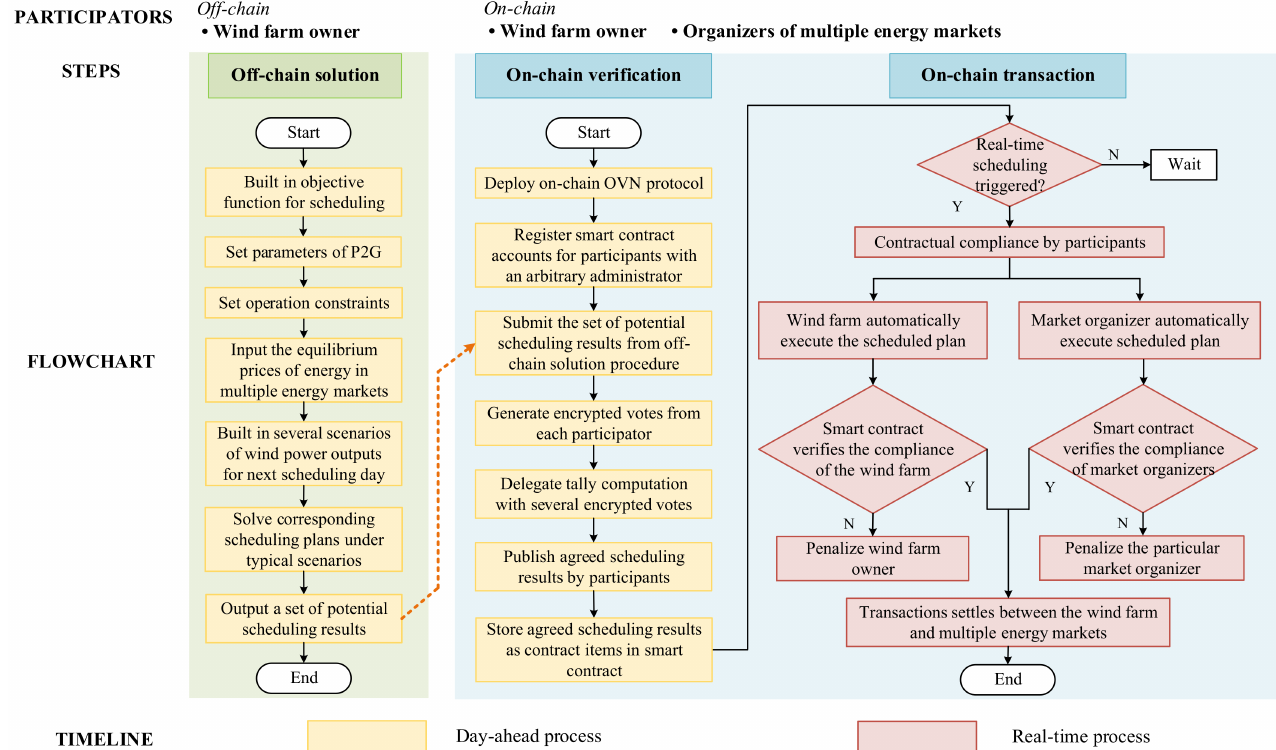
Figure 3. Processes in implementing the smart-contract-enabled automatic scheduling for a wind farm with P2G system in multiple energy